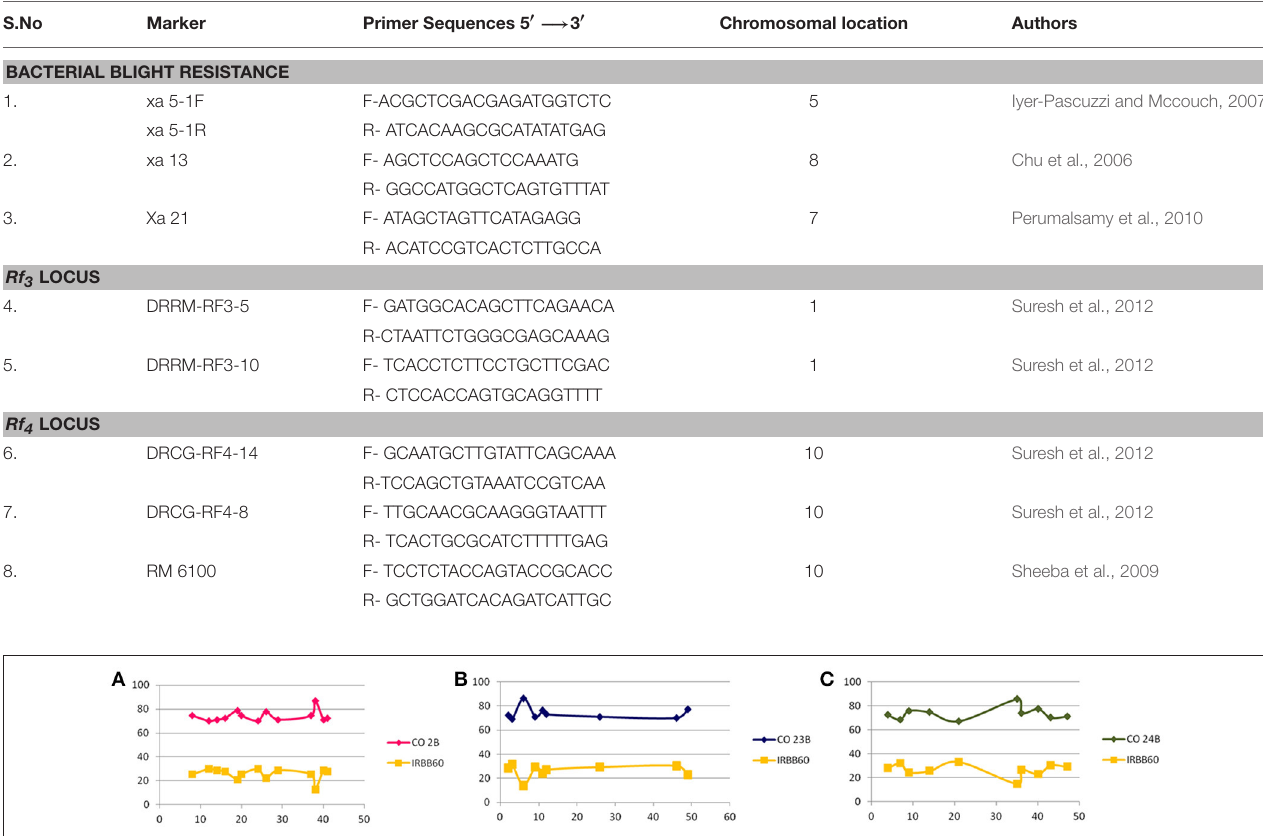
TABLE 1 | Details of markers used for bacterial blight resistance and fertility restoration. S.No Marker Primer Sequences 5 ′ −→ 3 ′ Chromosomal location